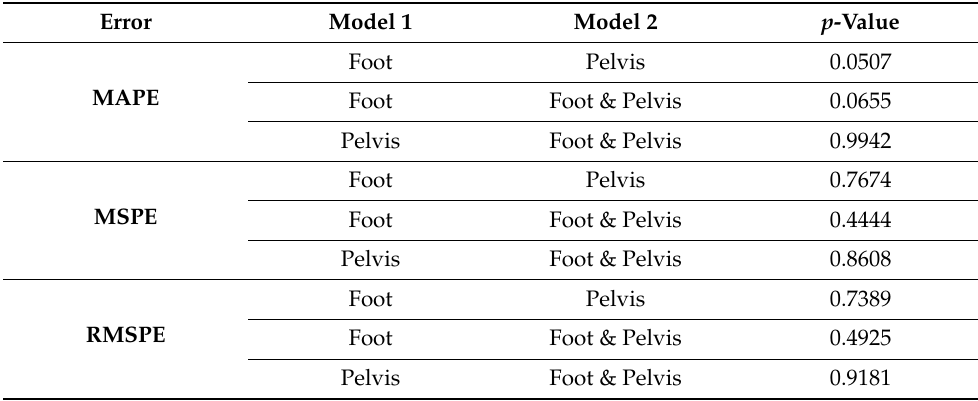
Figure 6. Result of prediction errors. The distribution of each prediction error for the 100-time iterations is shown (The mean values for MAPE are foot (0.865 s), pelvis (0.921 s), and foot & pelvis (0.918 s), for MSPE are: foot (1.124 s), pelvis (1.162 s), and foot & pelvis (1.192 s), and for RMSPE are foot (1.046 s), pelvis (1.065 s), and foot & pelvis (1.075 s)). There was no significant difference of prediction errors between different sensor locations. Table 7. Multiple comparisons between different models.